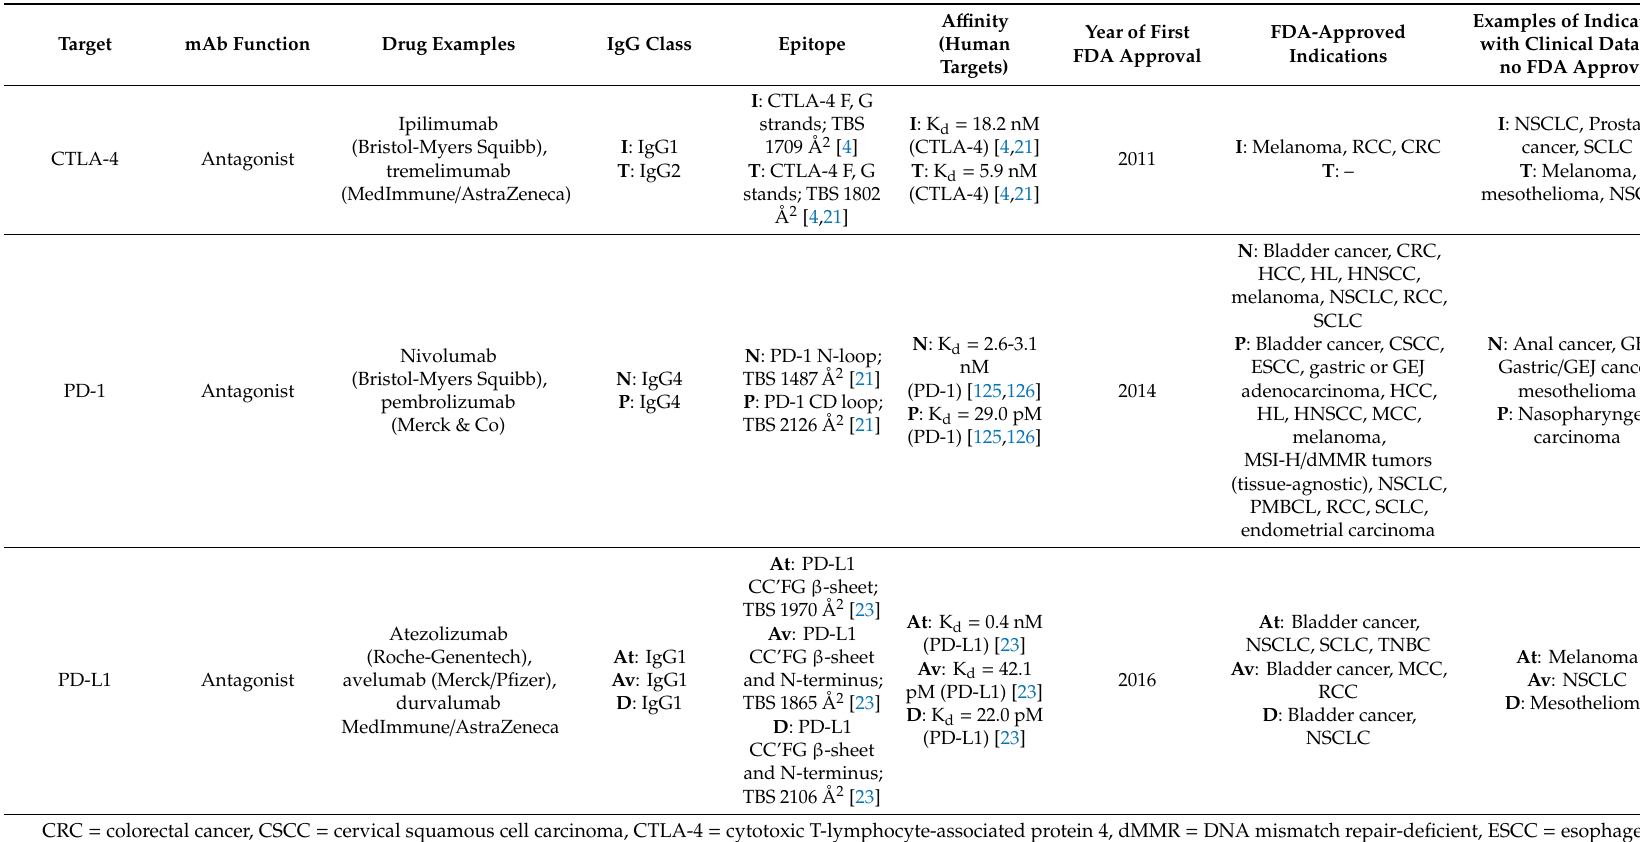
Table A1. Summary of immune checkpoint modulator classes and